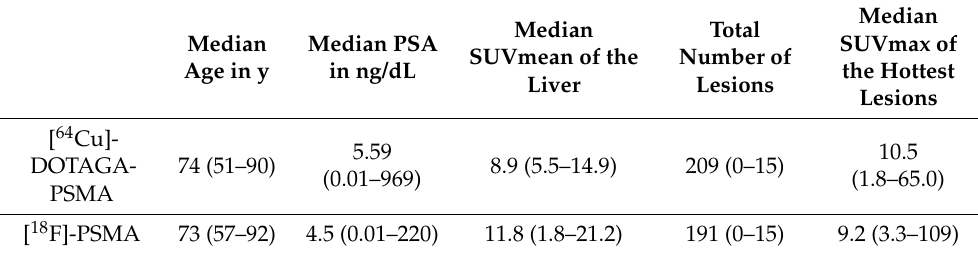
Table 1. Patient characteristic of the two groups. Ranges are given in parenthesis.